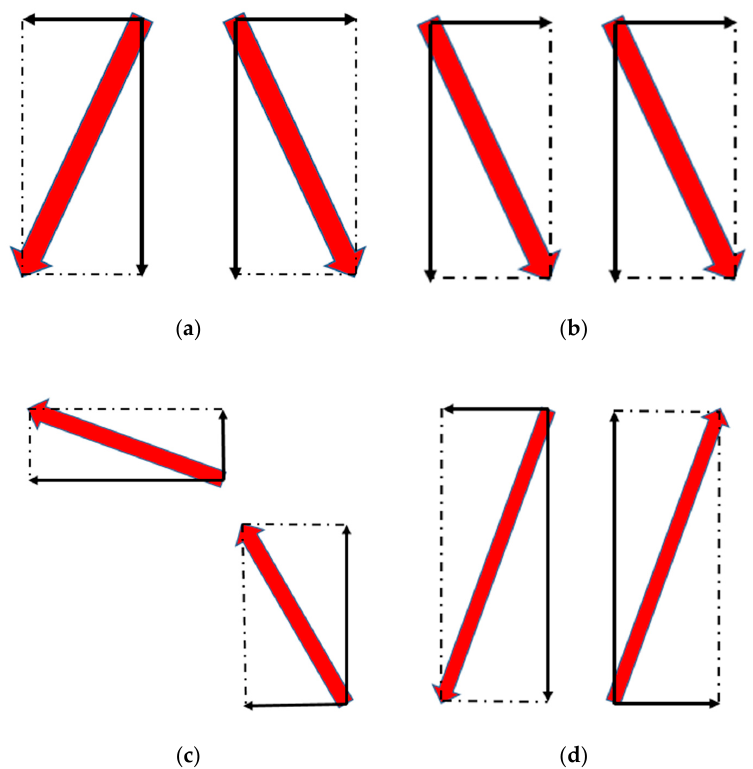
Figure 5. Schematic diagram of velocity fields for different types of particles. ( a ) Type I; ( b ) Type II; ( c ) Type III; ( d ) Type IV.